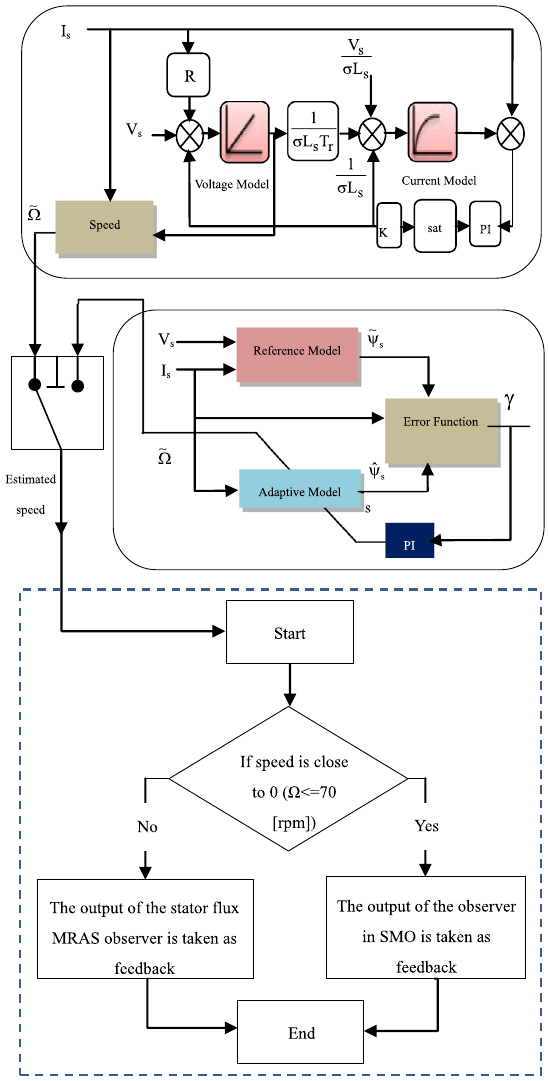
Fig. 9 Dual observer SMO-SMRAS